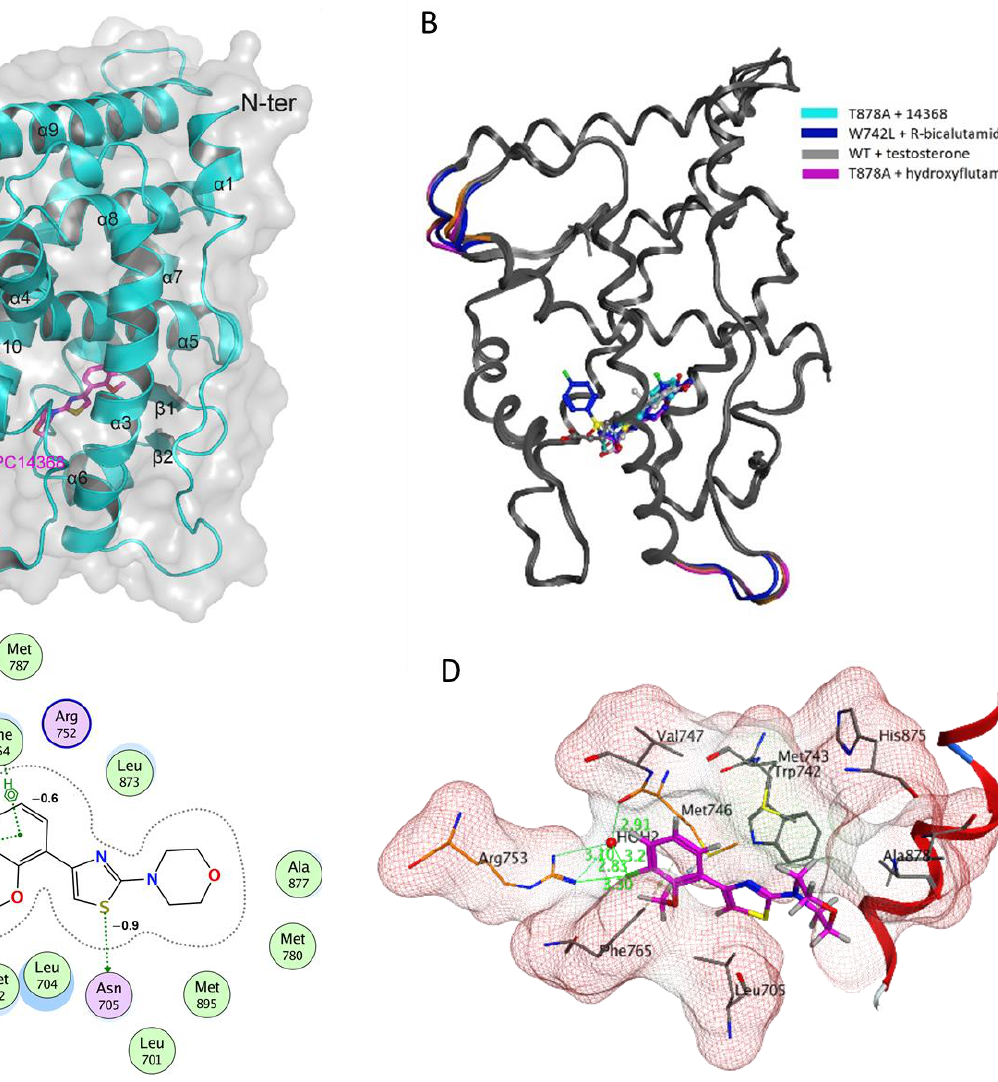
Figure 3. ( A ) Cartoon representation of the T878A-LBD structure in complex with VPC14368 (in magenta) shown in ball-and-stick. ( B ) Superposition of T878A-VPC14368 (in cyan) with WT-LBD- testosterone (PDB: 2AM9, in grey), T878A-hydroxyflutamide (2AX6, in magenta) and W742L-R- bicalutamide (PDB: 1Z95, in blue). Moving loops and ligands are highlighted in the corresponding colors. ( C ) Polar (pink) and hydrophobic (green) AR LBD residues interacting with VPC14368. Energies of bonds estimated with MOE are shown in kcal/mol. ( D ) Details of VPC14368 binding to the ABS. The binding is established by a few electrostatic interactions with R753 (in orange) and a water molecule (in blue) and mostly by hydrophobic interactions with surrounding residues (in grey). VPC14368 (in magenta) and protein-interacting residues are presented in ball-and-stick and the rest of the protein is shown a semi-transparent cartoon. Dashed lines indicate the hydrogen bonds and the numbers refer to distances in Å . Red ribbon represents helix 12 (residues 893 – 903).